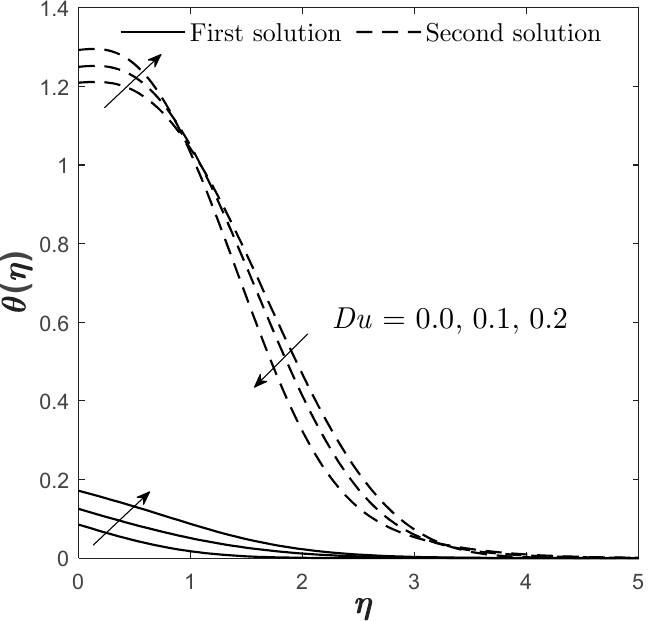
Figure 15. Plots of θ ( η ) for varied Du when N = Rd = Sc = Sr = 1, λ = − 1, φ 2 = 0.01, and Bi = Figure 15. Plots of